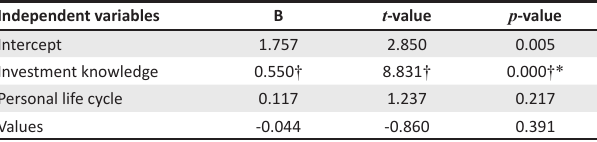
TABLE 5: Influence of the independent variables on perceived successful investment planning. Independent variables